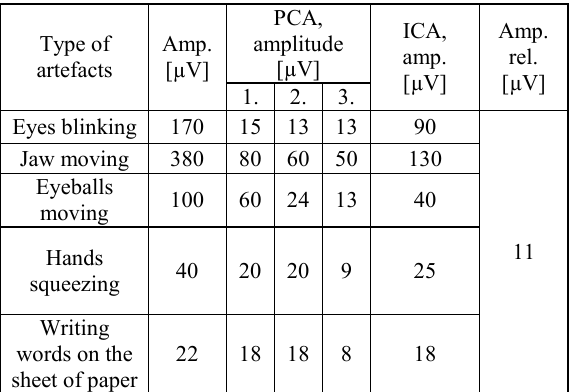
Table 2 . Stationary amplifier. Amp - amplitude of EEG signal with artefacts, Amp. rel. - amplitude of EEG signal of relaxation